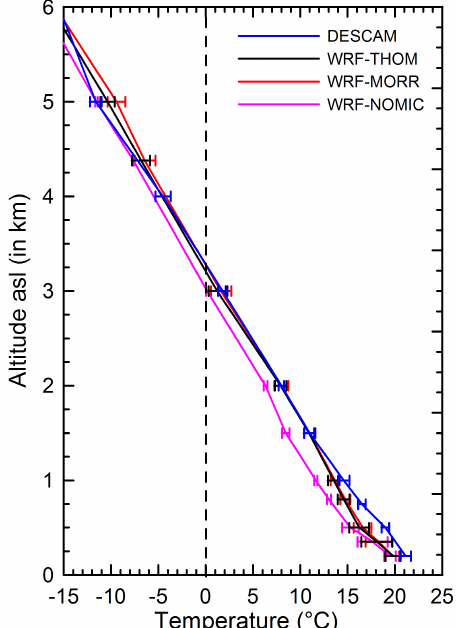
Figure 11. Mean vertical profile of the temperature obtained in the column represented in the Figure 10b for DESCAM, WRF-MORR, WRF-THOM and WRF-NOMIC simulations at 07:00